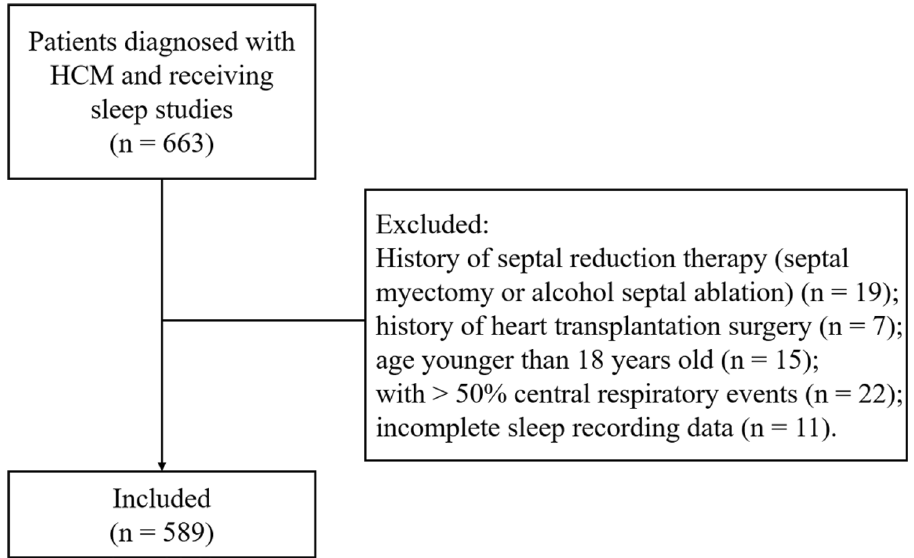
Figure 2. The study